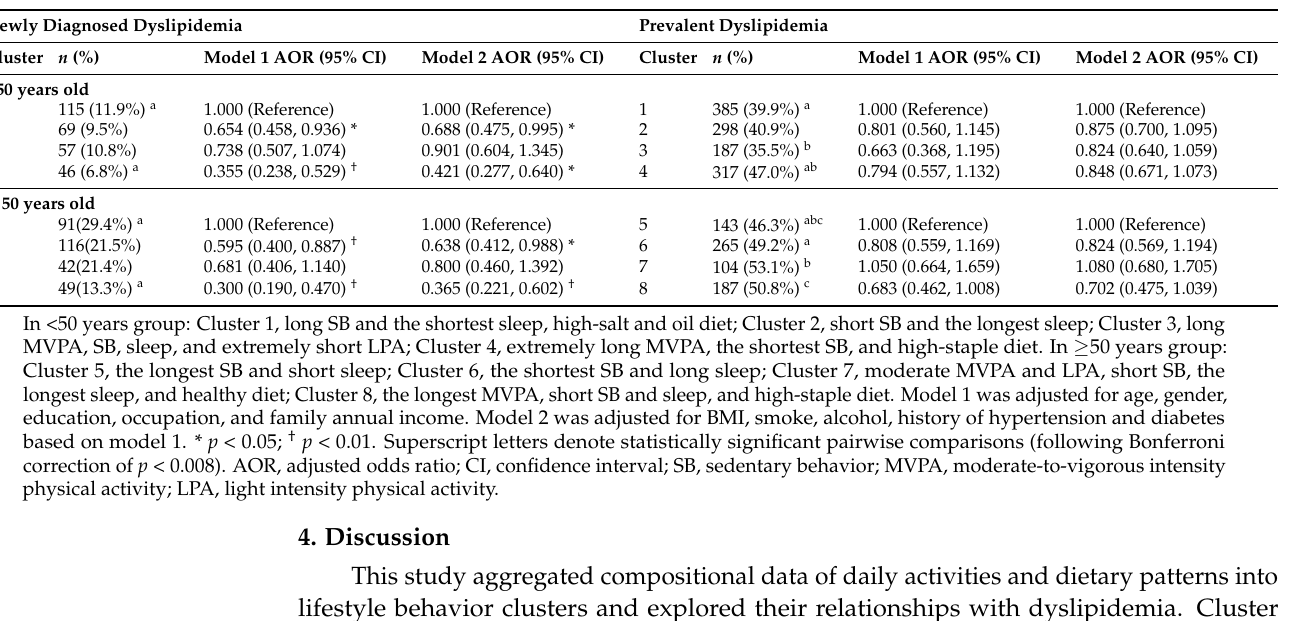
Table 4. Associations between dyslipidemia and lifestyle clusters among